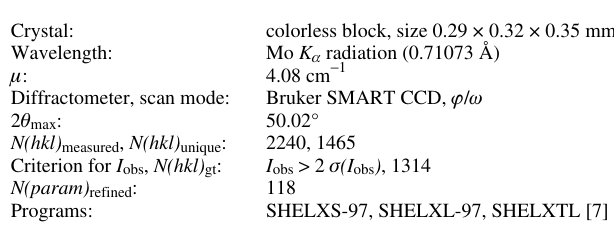
(figure, top). The dihedral angle between the oxadiazole ring and the pyridine ring is 12.26(2)° in the same molecule. There exists oxadiazoleringwiththedistancesof3.592Åand3.233Å(figure, bottom),whichcontributetothestabilityof thecrystalpacking. Table 1. Data collection and handling.